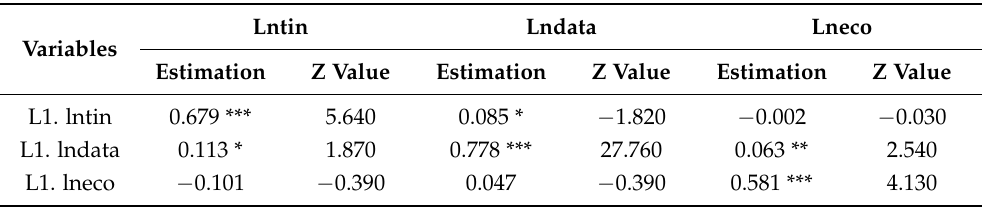
Table 8. GMM estimation